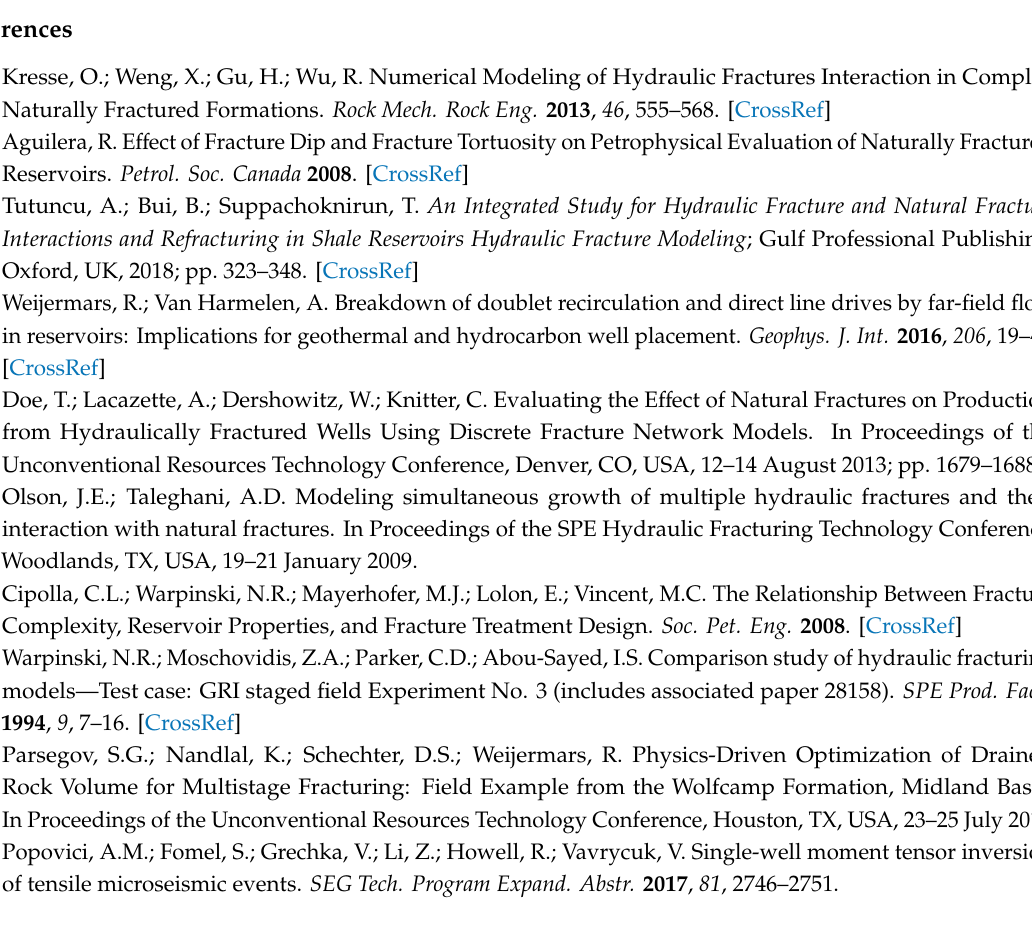
Figure A7. REV near single hydraulic fracture (horizontal red line) with upscaled natural fractures (dashed black lines) based on HFTS field data.